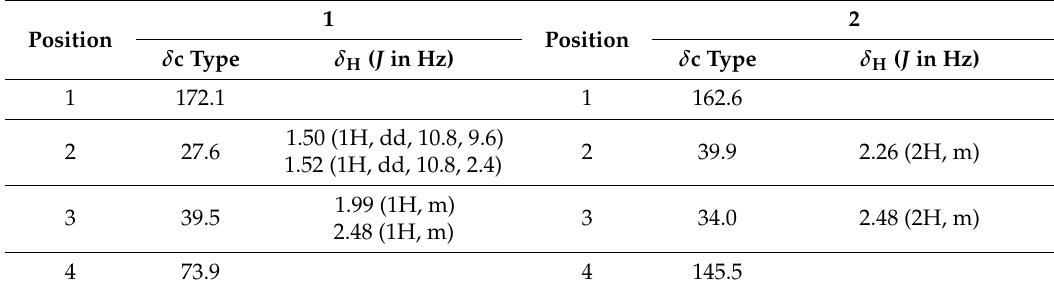
Table 1. 1 H (600 MHz) and 13 C-NMR (150 MHz) spectral data for compounds 1 and 2 (in DMSO- d 6 ). 1 Position